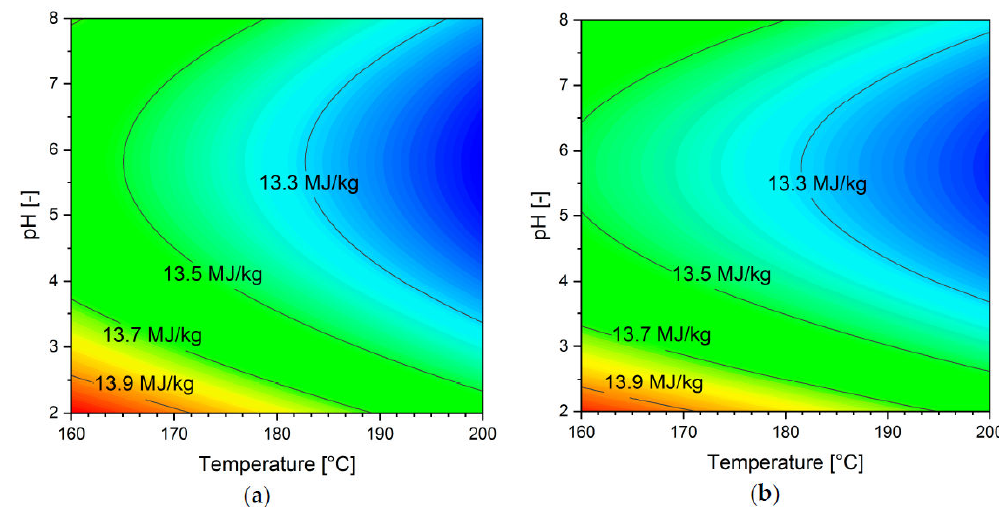
Figure A2. Regression model contour plots showing the dependence of the higher heating value (MJ kg TS − 1 ) on reaction temperature and initial pH based on a model referring to ( a ) holding time and ( b ) reaction time (contours shown at the respective time at the corresponding center point).